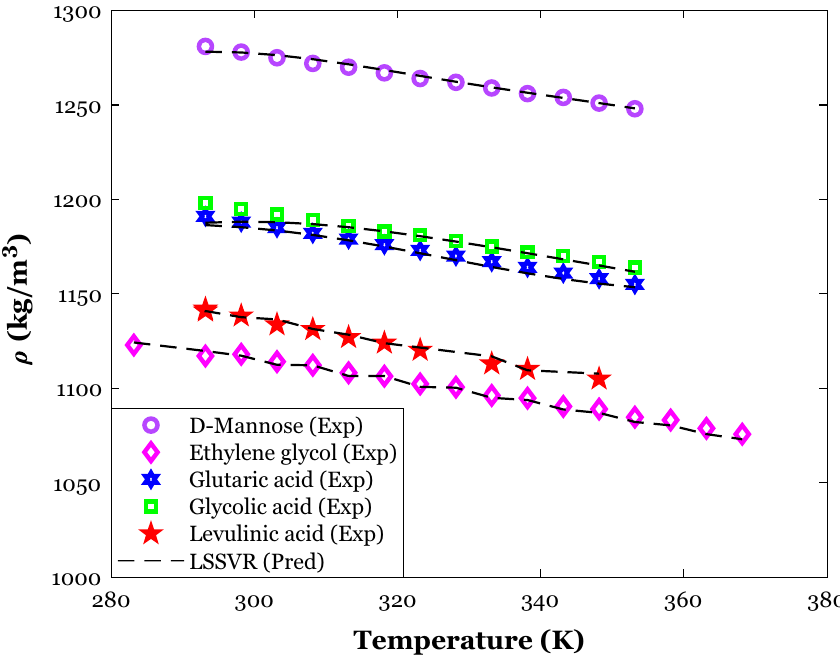
Figure 8. The excellent performance of the LSSVR model for correctly identifying the HBD effect on the density of Choline chloride as an